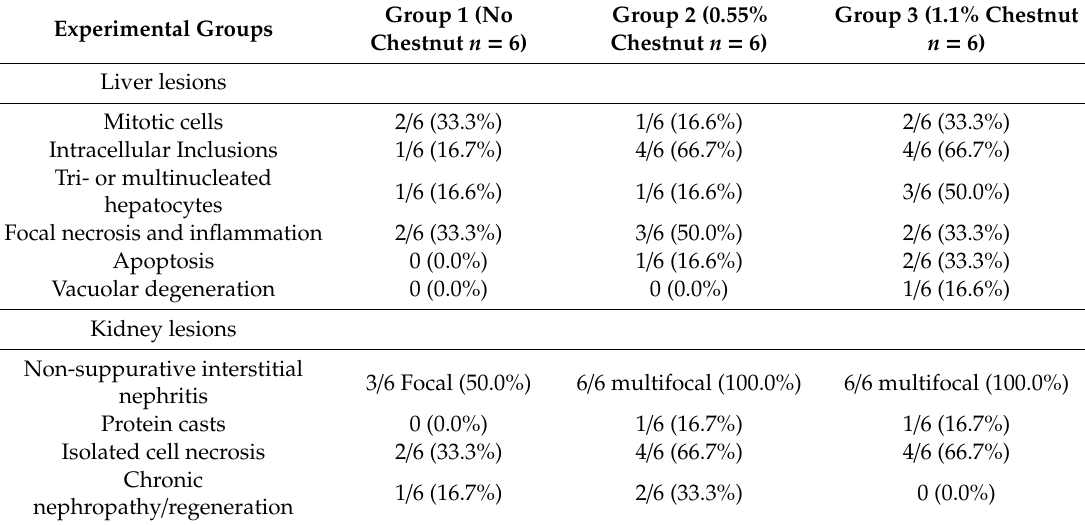
Table 5. Histological classification of liver and kidney lesions in